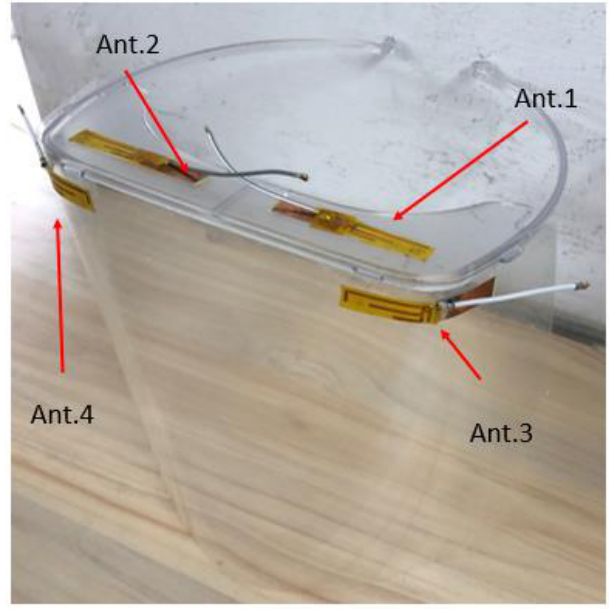
Figure 14. Physical diagram of the antenna system on a medical mask.